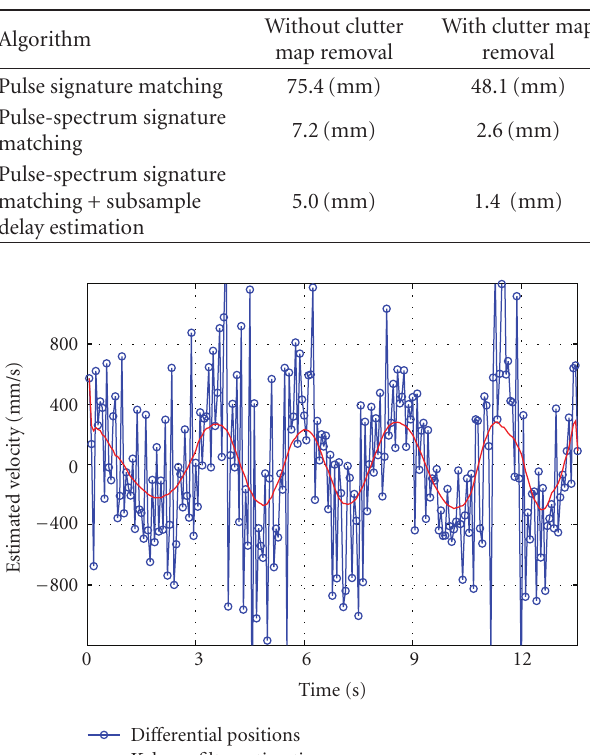
Table 1: Comparison of the ranging techniques in terms of RMSE between the real and estimated position for each measurement i .